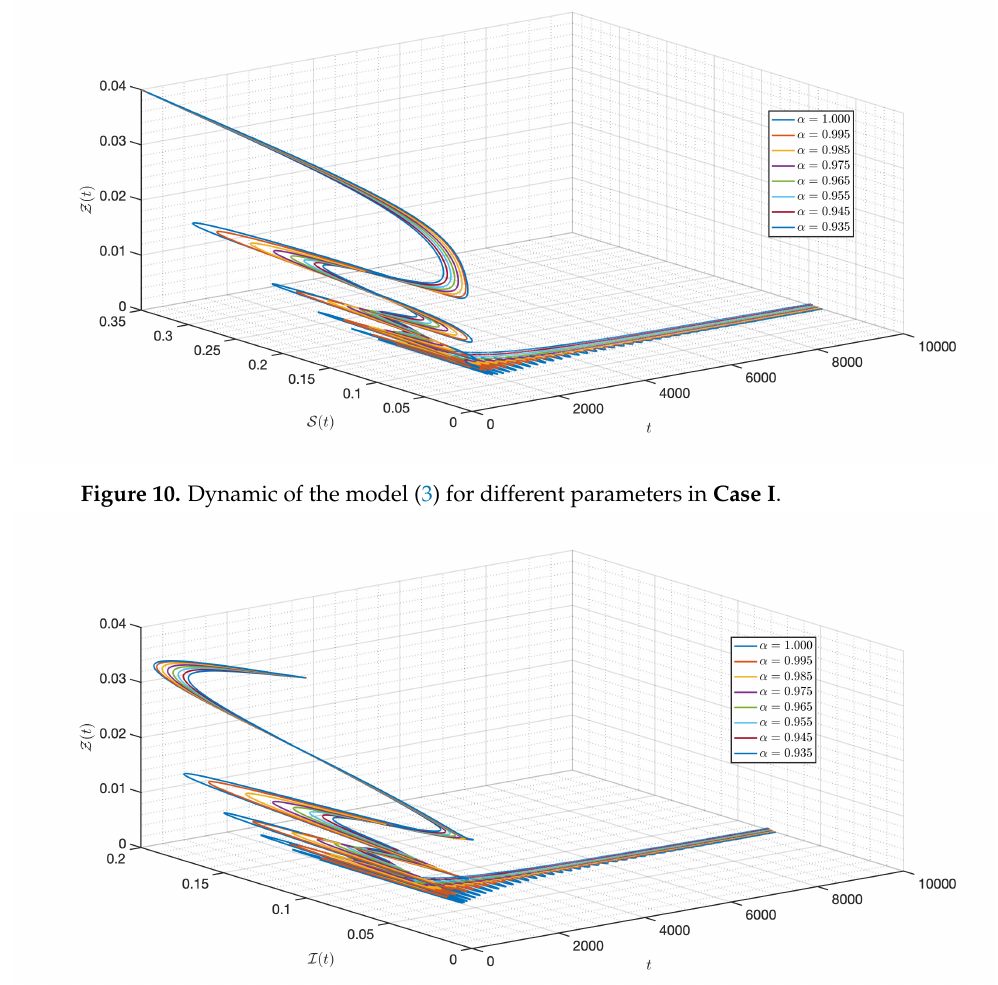
Figure 11. Dynamics of the model (3) for different parameters in Case I